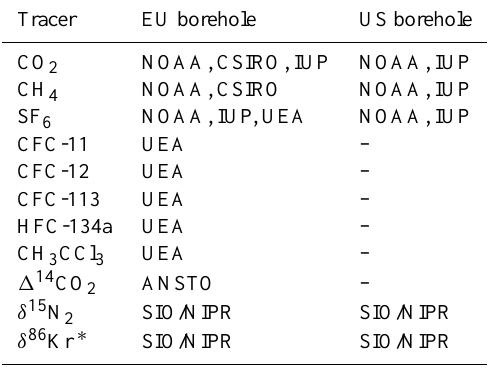
Fig. 2. Comparison of (a) CO 2 and (b) CH 4 data in the lock-in zone of the two boreholes. Data from three laboratories are averaged; the 1 σ uncertainty bar is a combination of analytical and sampling uncertainties as specified in Sect. 2.7. Curves are modeled profiles using the CIC model, see Sect.